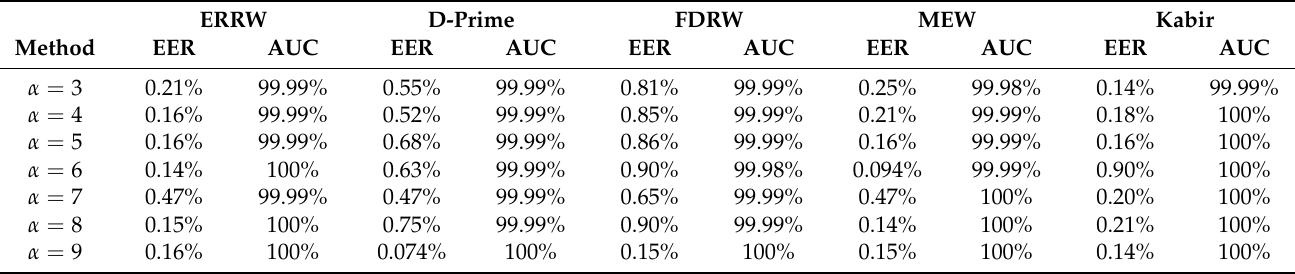
Table 4. EER and AUC values obtained using various fusion methods and α values for β =